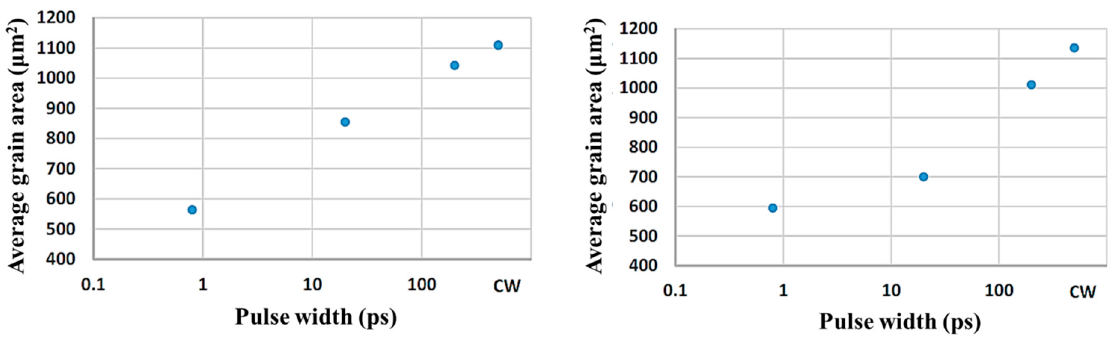
Figure 16. ( a ) A gear a half-inch in diameter 3D printed by fs laser; ( b ) fs sintered tungsten feature; ( c ) fs sintered tungsten with a small circular feature with a hole; ( d ) 3D printed thin wall of a 100 microns (Adapted from reference [44]).